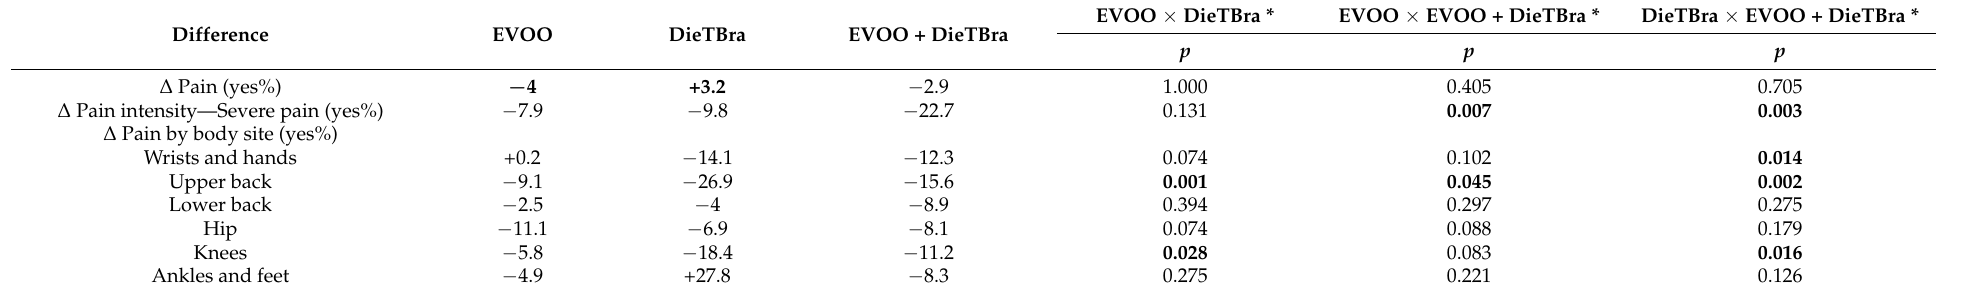
Table 3. Comparison of percentage change in the prevalence of the outcome variables according to intervention group, after 12-week follow-up.